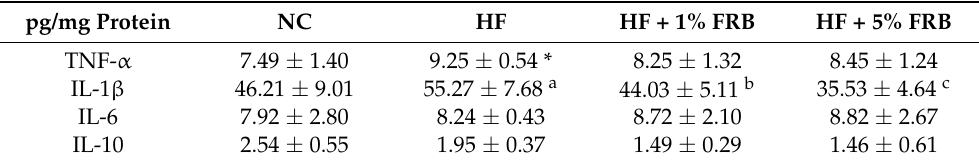
Table 3. Effects of the water extract of fermented rice bran (FRB) on liver cytokine levels in aged rats with high-fat (HF) diet feeding.